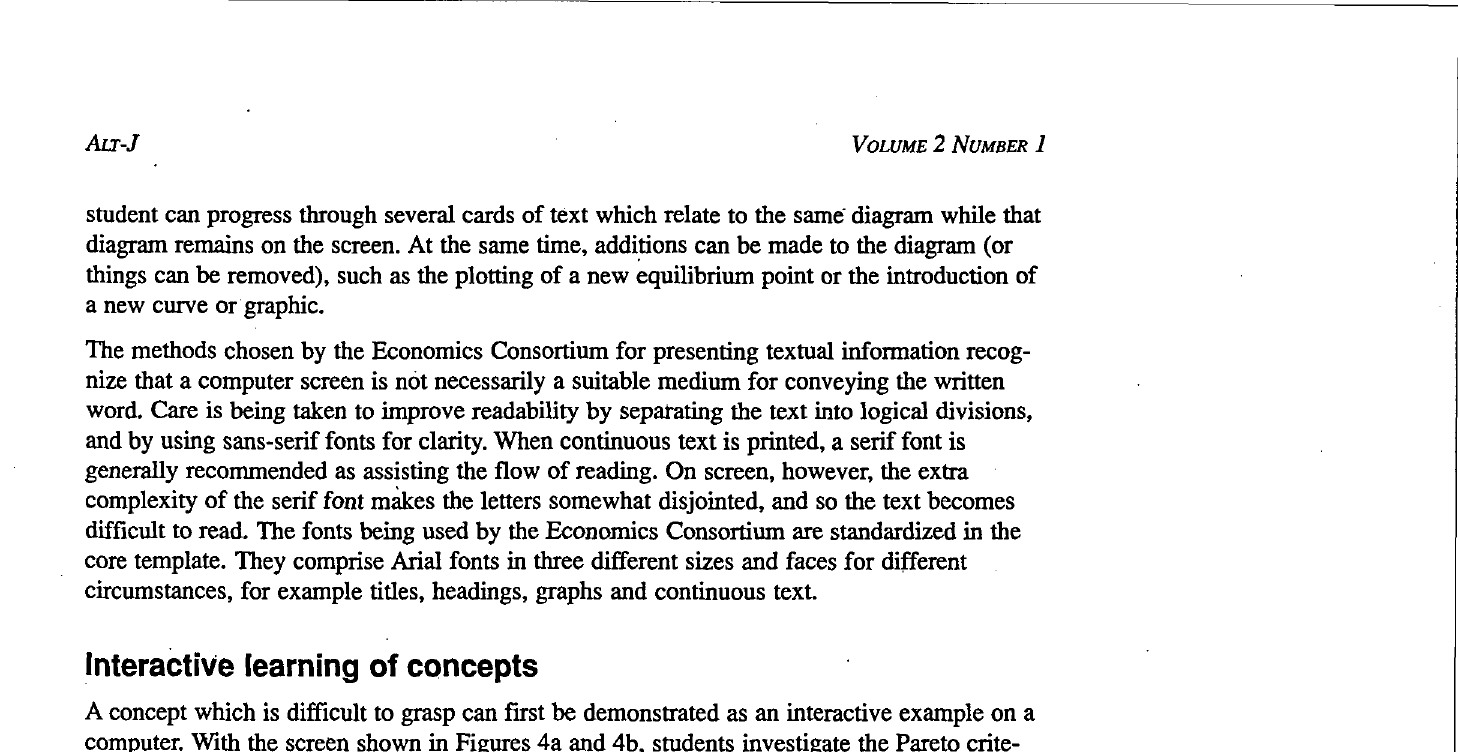
Figure 4b: Learning the theory by